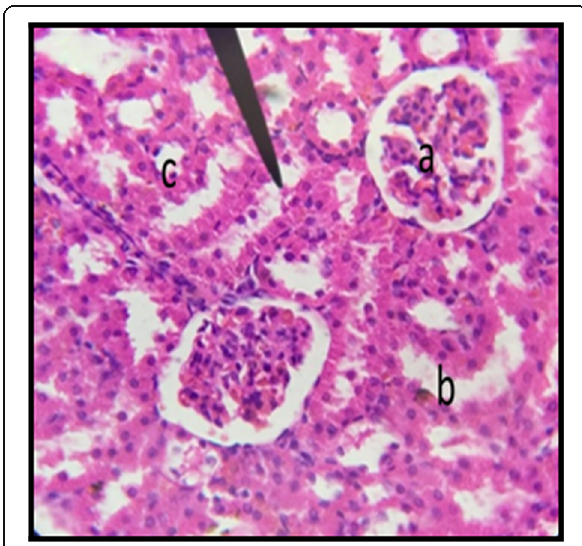
Fig. 8 Kidney Section of Female Rat (100 mg/kg/day) X400. a damage to nephron along with infiltration of RBCs